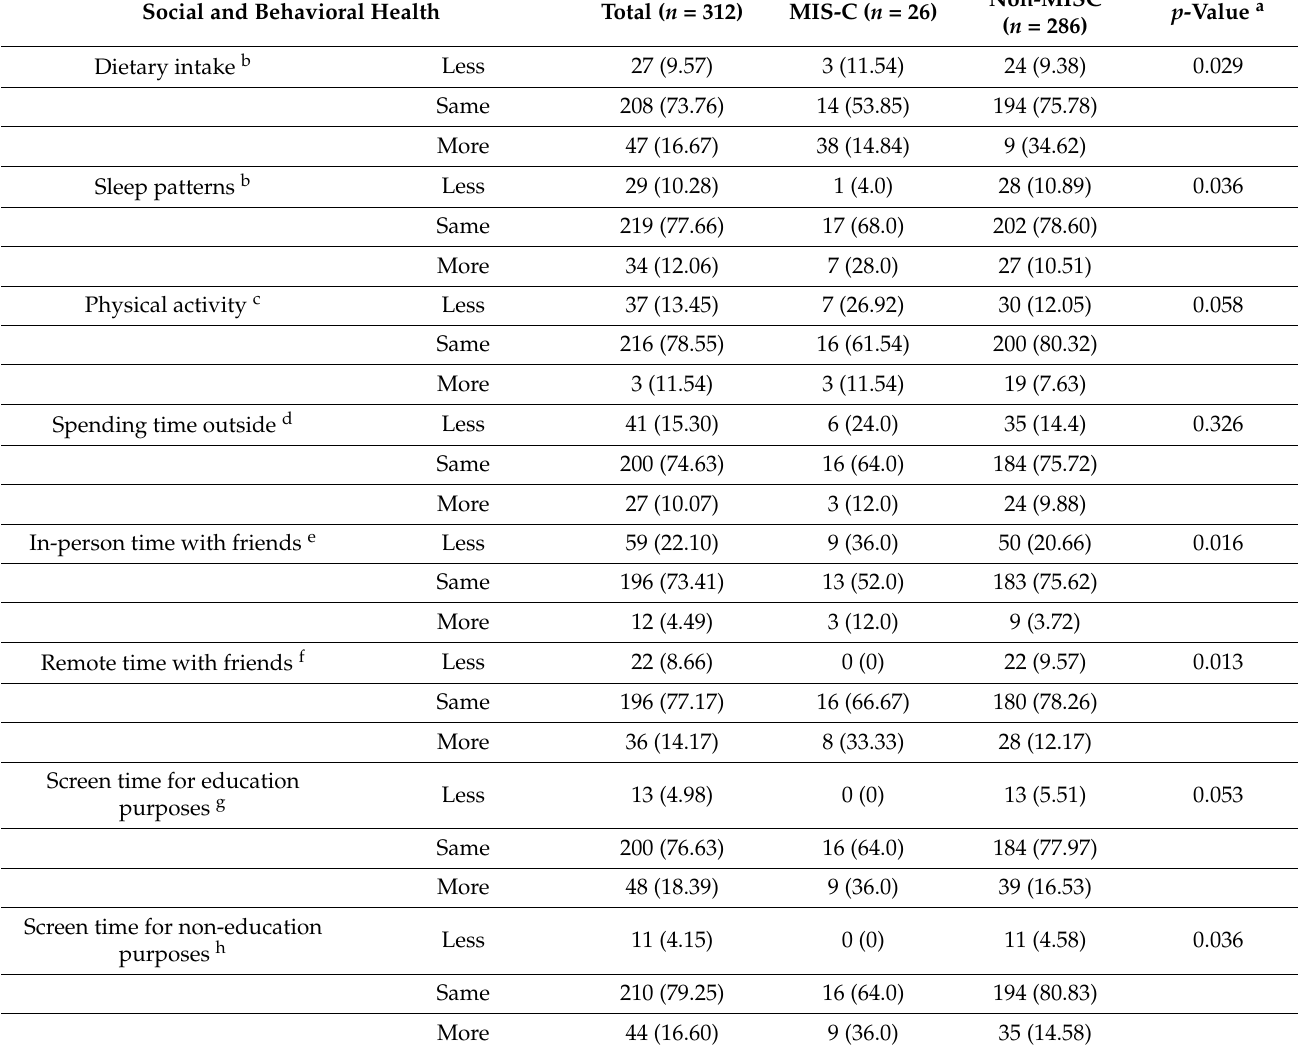
Table 2 summarizes caregiver-reported long-term effects on social and behavioral health in MIS-C versus non-MISC children compared to before the COVID-19 pandemic. Non-MISC children were more likely to report increased dietary intake than MIS-C children (34.62% vs. 14.84%, p = 0.029). Twenty-eight percent of MIS-C children reported sleeping more while 10.51% of non-MISC children reported sleeping more since the start of the pandemic ( p = 0.036). Compared to non-MISC children, MIS-C children spent more time with friends either in-person (12.0% vs. 3.72%, p = 0.016) or remotely (33.33% vs. 12.17%, p = 0.013) since the start of the pandemic. However, more than one-third of MIS-C children reported less social connection. MIS-C children also were more likely to have longer screen time for non-educational purposes than non-MISC children (36.0% vs. 14.58%, p = 0.036). Caregivers reported that about 40% of MIS-C children had difficulty in concentrating or angry outbursts since the pandemic, while about 20% non-MISC children reported such changes ( p < 0.05 for both comparisons). Table 2. Caregiver-reported long-term effect of social and behavioral health in MIS-C versus non- MISC children compared to before COVID-19